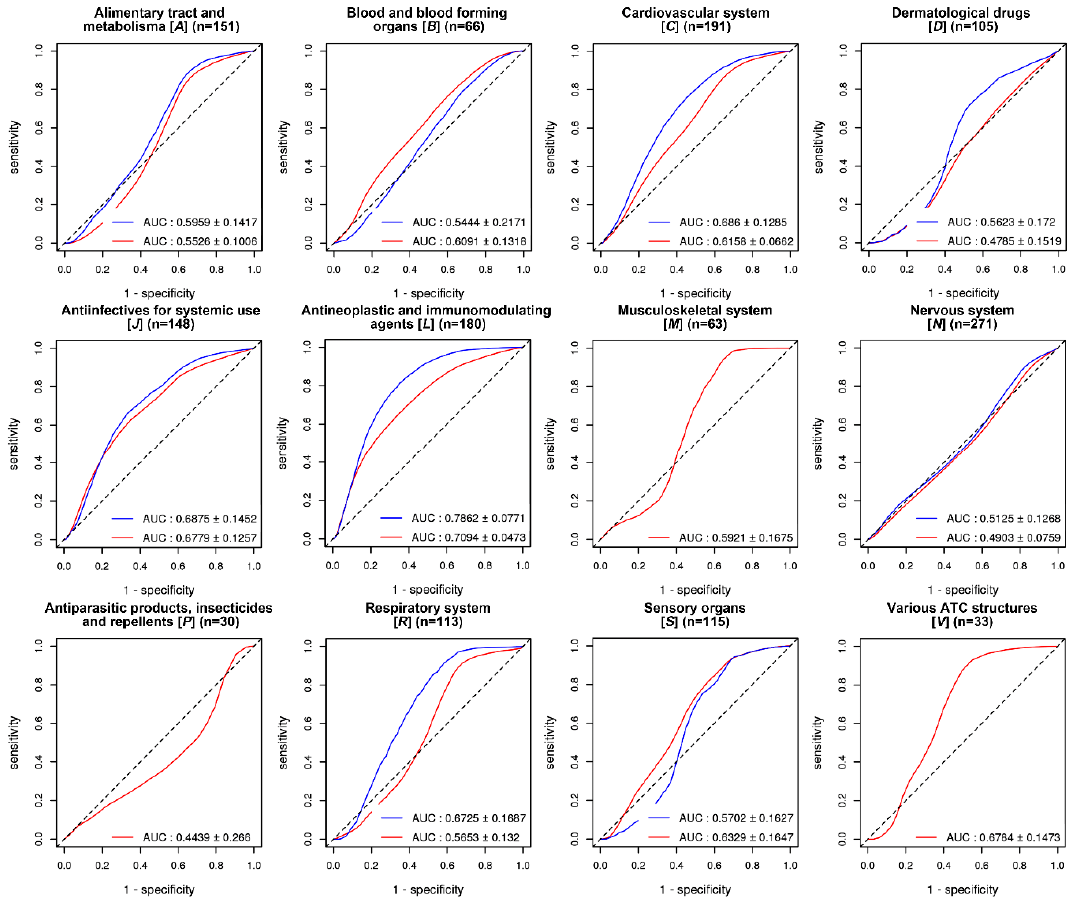
Figure 4. Drug-level GVB evaluation in predicting the variant-drug associations in PharmGKB across different drugs in 12 anatomical main groups. Drug-level GVB SIFT for the 2504 individual genomes of